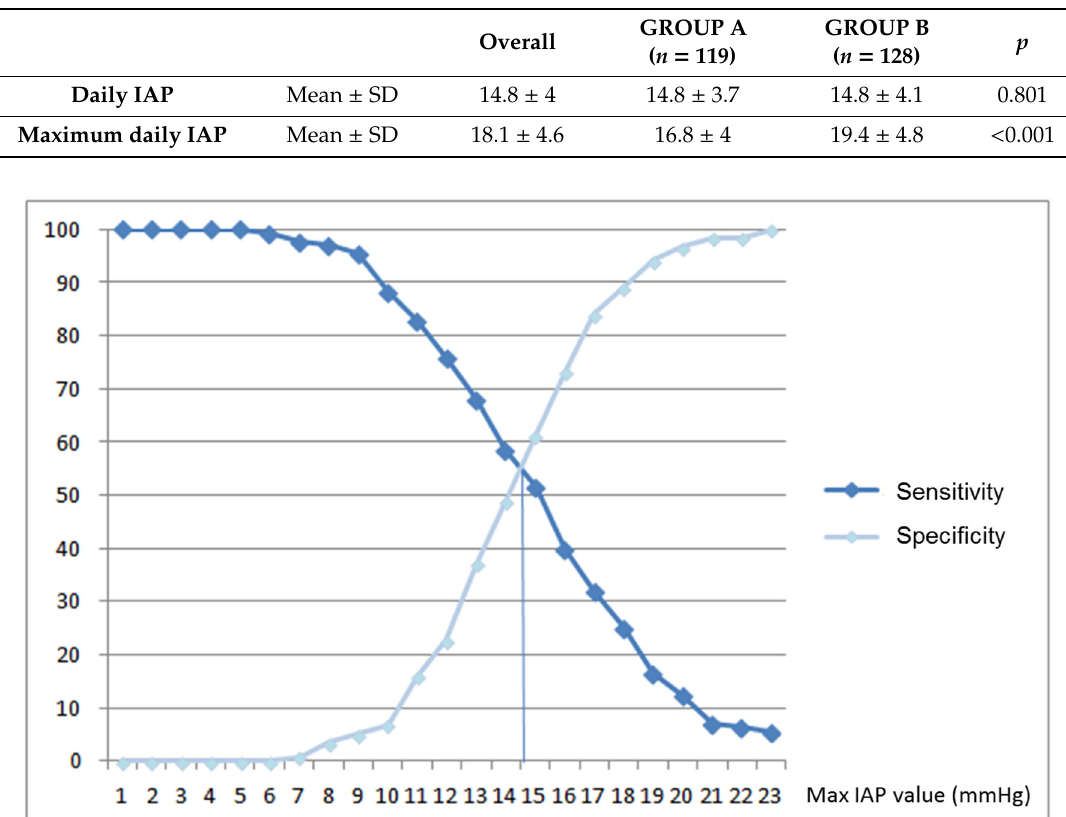
Figure 2. Sensitivity and specificity of maximum intraabdominal pressure (IAP) in predicting enteral nutrition intolerance. The best IAP cut-off of 14 mmHg showed a sensitivity of 58.6% and a specificity of 48.7%.